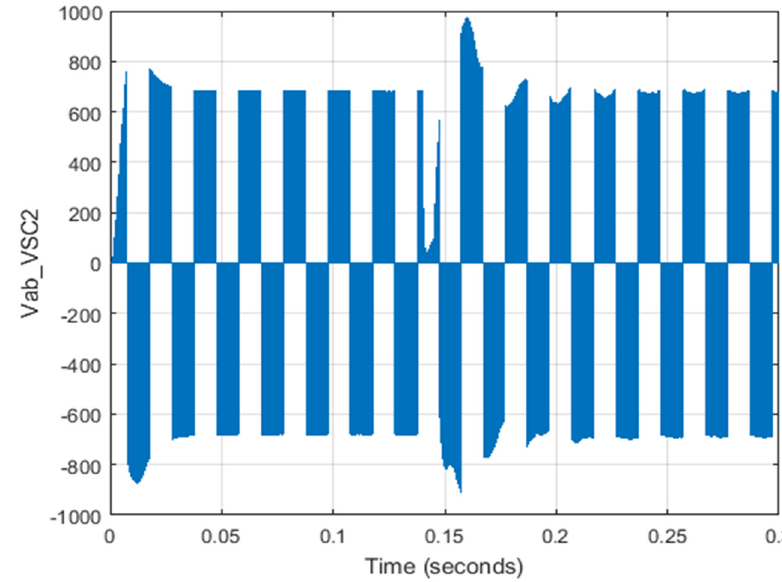
Figure 24. Two-phase voltage ab for VSC-2.